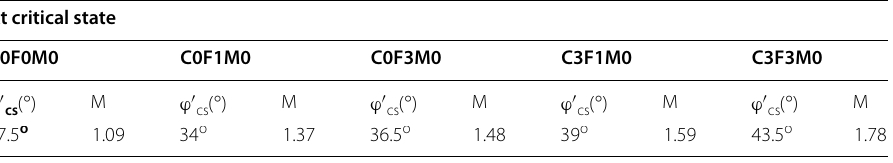
Table. 5 Slope of the critical state line, M for unreinforced, fibre reinforced, and fibre reinforced cemented Toyoura sand from CID compression tests At critical state